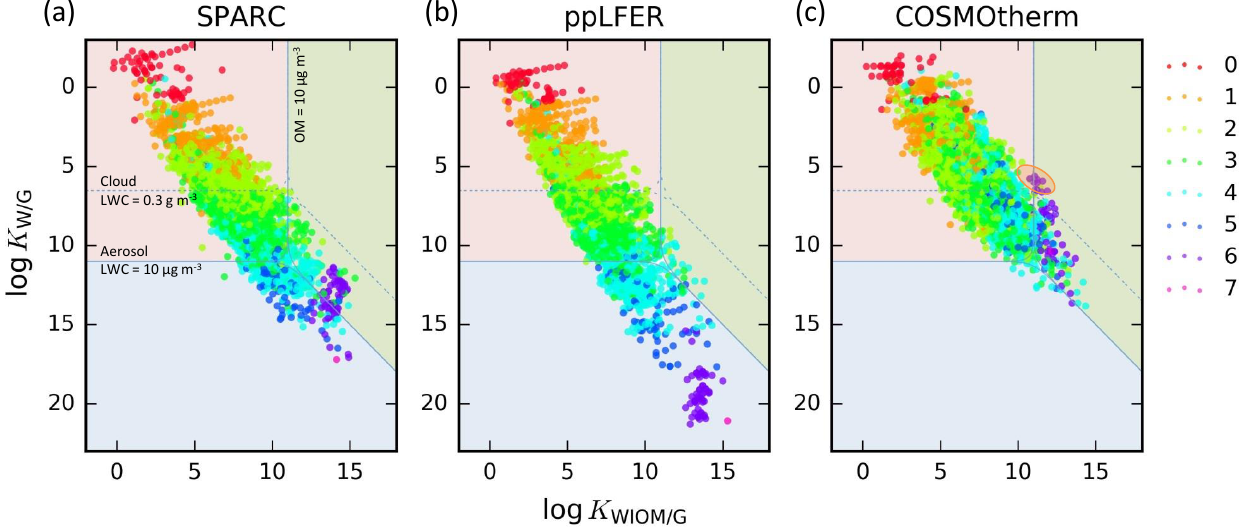
Figure 3. Partitioning space plot, showing in pink, blue, and green the combinations of partitioning properties that lead to dominant equilib- rium partitioning to the gas, aqueous, and WIOM phases, respectively. The blue solid and dotted lines are boundaries for an aerosol scenario (LWC: 10µgm − 3 ; OM: 10µgm − 3 ) and a cloud scenario (LWC: 0.3gm − 3 ; OM: 10µgm − 3 ), respectively. The differently colored dots indicate the number of functional groups in the